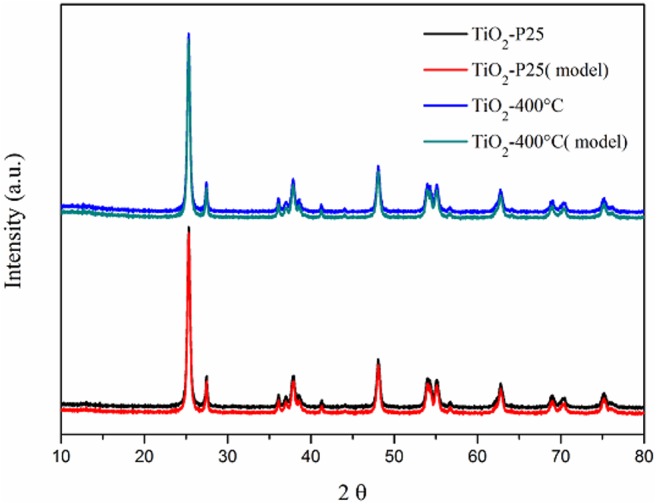
X-ray diffraction patterns of TiO2-P25 and TiO2-400 °C.